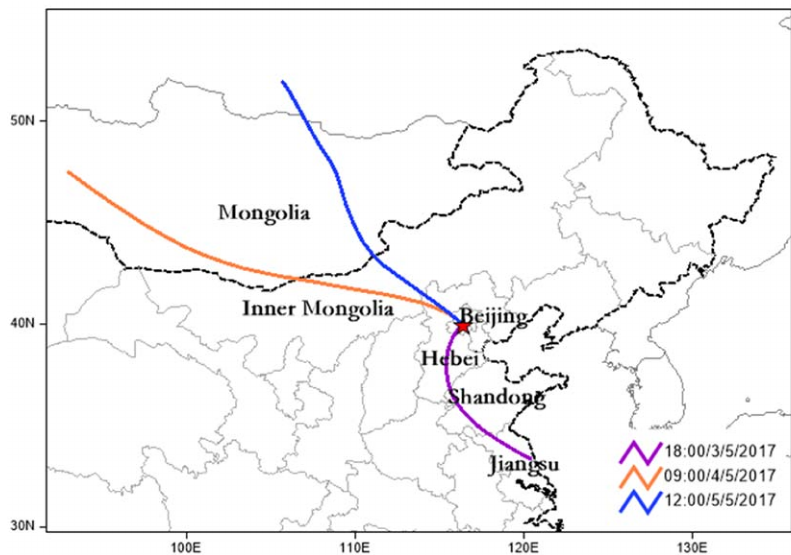
Figure 6. Isentropic backward trajectories of mineral aerosols before, during, and after the dust storm. The purple line represents the backward trajectory of the mineral aerosols before the dust storm (18:00 on 3 May 2017). The orange line represents the backward trajectory of the mineral aerosols during the dust storm (9:00 on 4 May 2017). The blue line represents the backward trajectory of the mineral aerosols after the dust storm (12:00 on 5 May